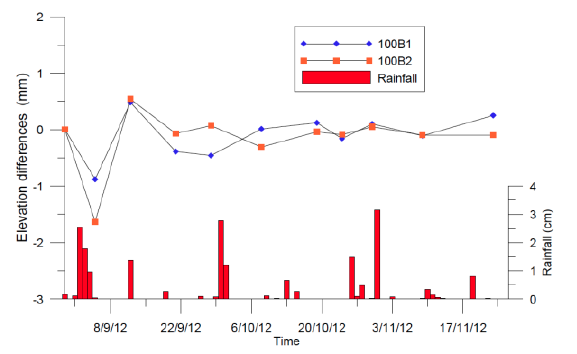
Figure 6. Elevation differences between two contiguous measurement epochs (h ti -h ti-1 ) for benchmarks fixed in soil: comparison between the behaviours of neighbour benchmarks founded at different depths.